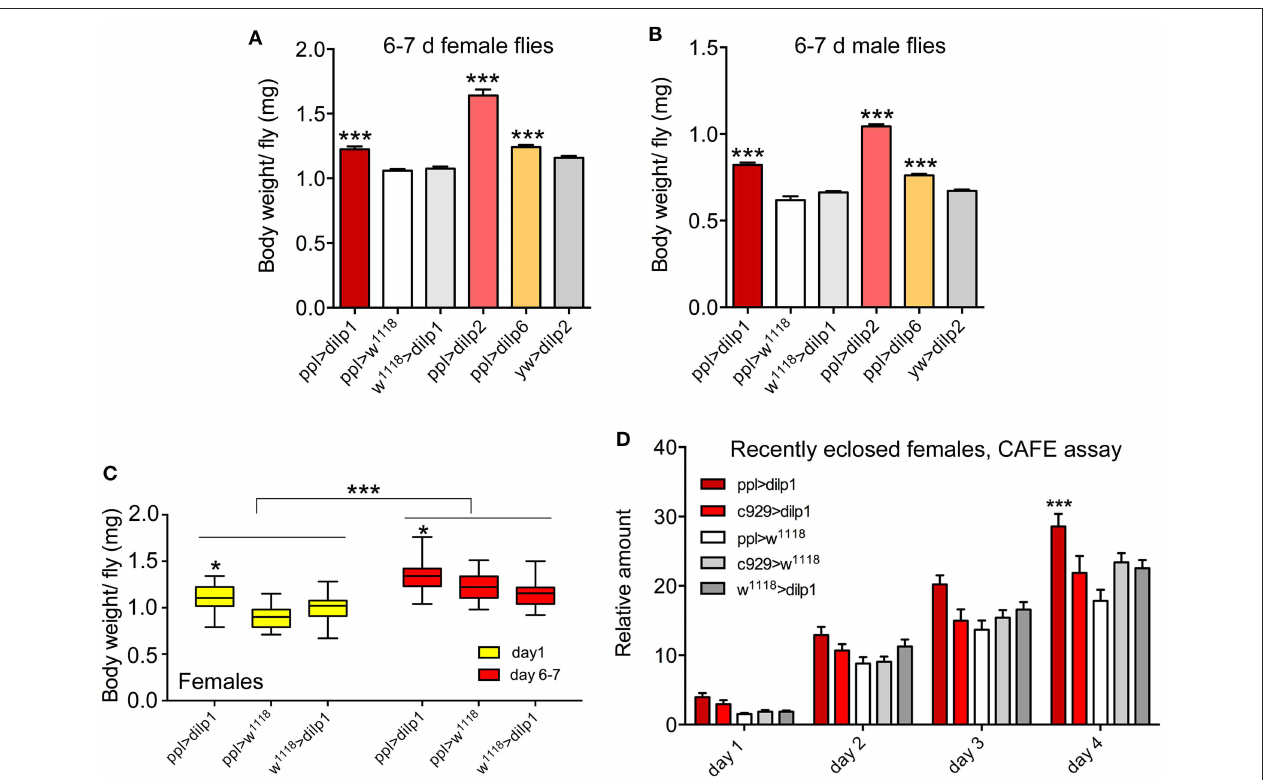
FIGURE 5 | Overexpression of dilp1 affects body mass and feeding in young adult flies. (A , B) Overexpression of dilp1, dilp2, and dilp6 in fat body ( ppl -Gal4) all lead to adult flies (1 week old) with increased body weight in both females and males. Data are presented as means ± S.E.M, n = 24–30 flies for each genotype from three independent replicates. Except for ppl > dilp2, 13 flies were used (* p < 0.05, one-way ANOVA followed with Tukey’s test). (C) Body weight of 6- to 7-day female flies is increased for all genotypes compared to 1-day flies and the ppl > dilp1 flies weigh more than controls at both time points. Data are presented as medians ± range, n = 23–27 flies for each genotype from three independent replicates (* p < 0.05, *** p < 0.001, two-way ANOVA followed with Tukey’s test). (D) Food intake (CAFE assay) is increased over 4 days (cumulative data shown) in flies overexpressing dilp1 in fat body, but not in neuroendocrine cells ( c929 -Gal4). Data are presented as means ± S.E.M, n = 15–30 flies for each genotype from three independent replicates (* p < 0.05, two-way ANOVA followed with Tukey’s